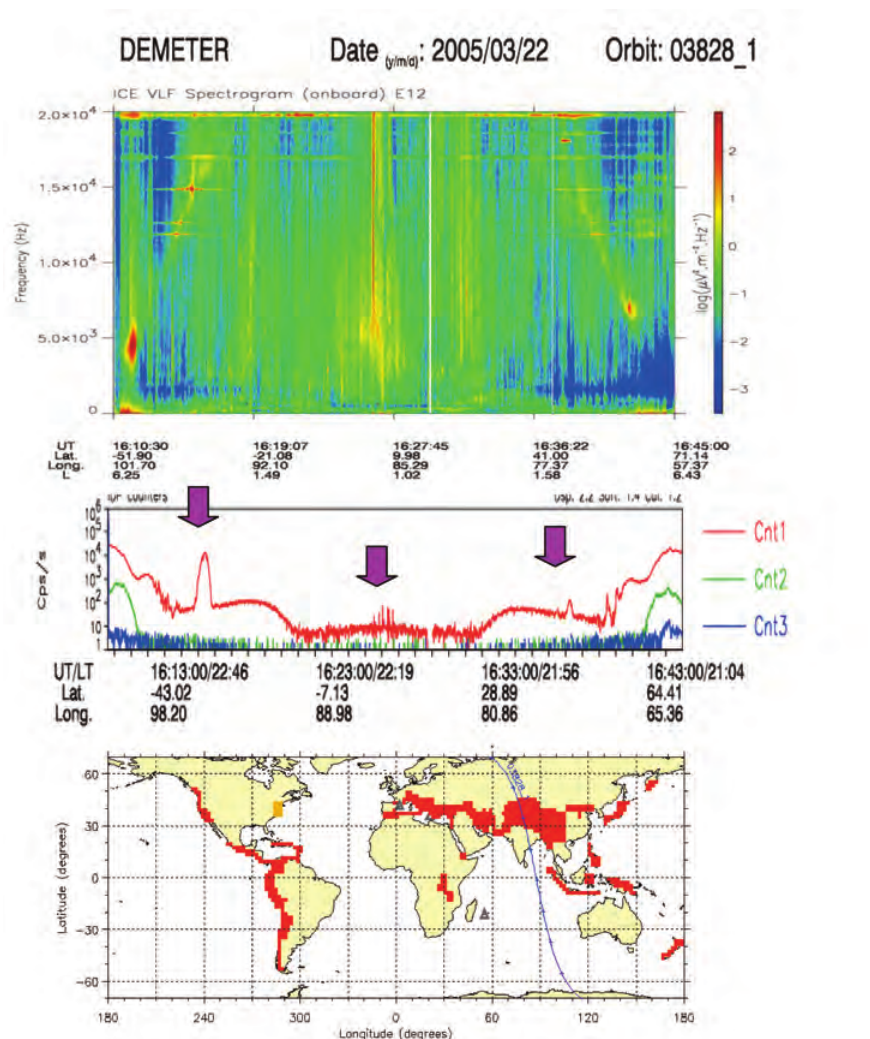
Figure 5. Observations from the DEMETER satellite related to the well-known giant (M = 8.8) earthquake that occurred in Sumatra (2.09˚N, 97.11˚E) on March 28, 2005. The observations reveal a flux-time profile with a sequence of short-lived intensity peaks observed above the region of the epicenter and accompanied by VLF wave activity in the range ~3 kHz to >20 kHz, as well as a pair of EBs, with one in the north and the other symmetric one in the